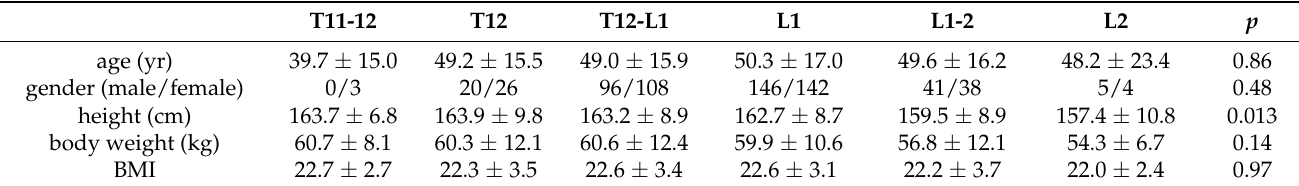
Table 1. The association between the conus medullaris level and patients’ backgrounds.